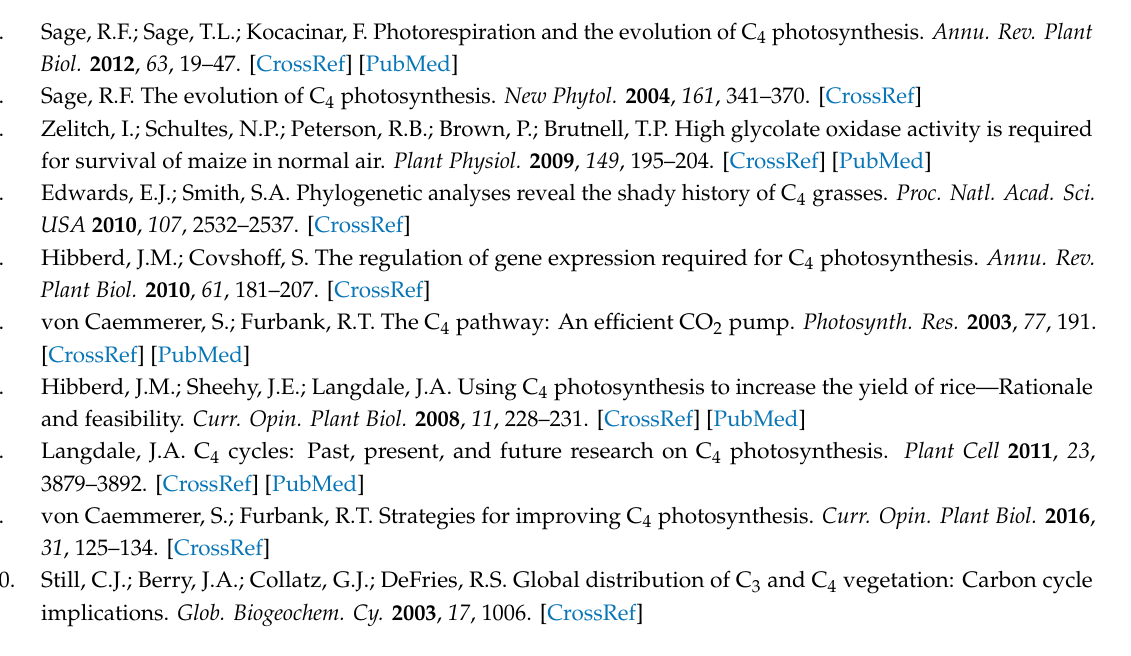
Table S1: List of re-sequenced sorghum accessions and their racial and geographic origins. Table S2: List of housekeeping genes and their genetic diversity. Table S3 List of SNPs under purifying selection. Table S4: List of SNPs under balancing selection. Table S5: Inter- and intra-species distribution of private alleles across 27 genes from C 4 gene families. Figure S1: Phylogenetic tree of 48 sorghum accessions based on CDS of 27 genes from C 4 gene families. Author Contributions: D.J. and E.M. conceived the original idea. Y.T., M.B.-P., S.T., A.C., and E.M. analyzed the data. Y.T. and B.G.-J. write the manuscript. All authors discussed the results and contributed to the